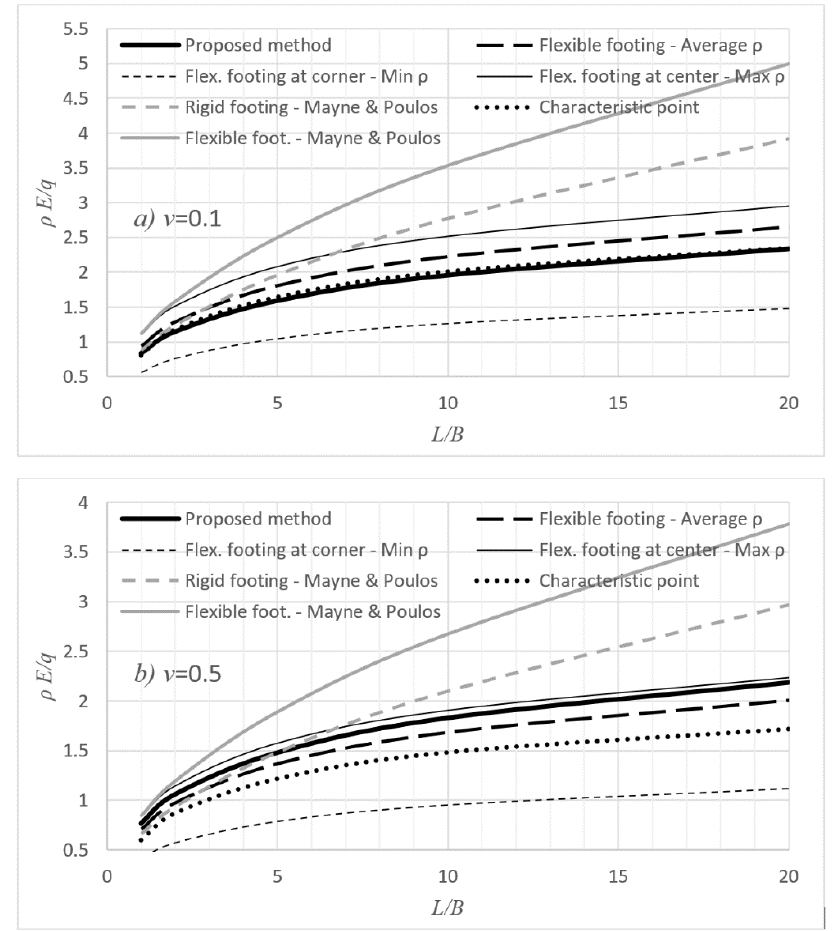
Figure 7. Comparison example: ( a ) v = 0.1 and ( b ) v = 0.5.